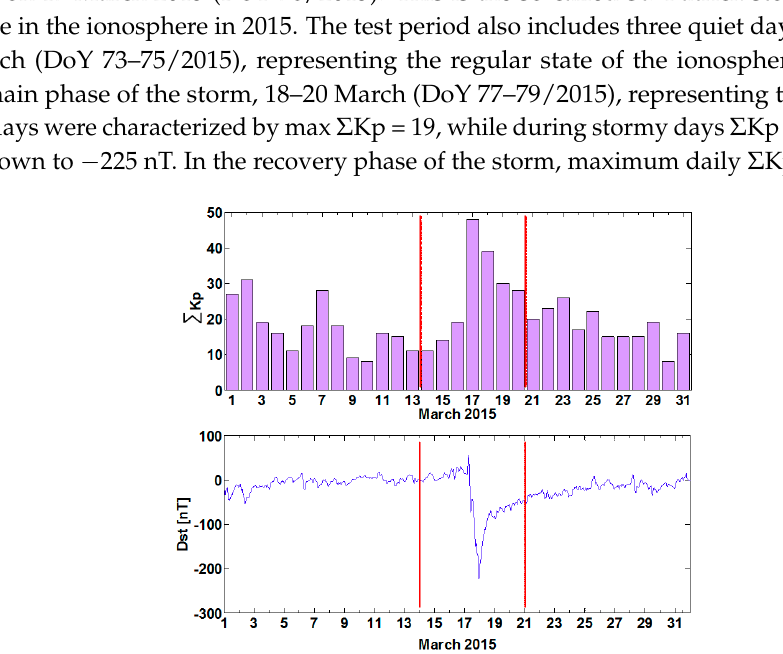
Figure 2. Variations of Σ Kp and Dst indices during March 2015. The vertical red lines highlight the seven test days (14–20 March 2015).